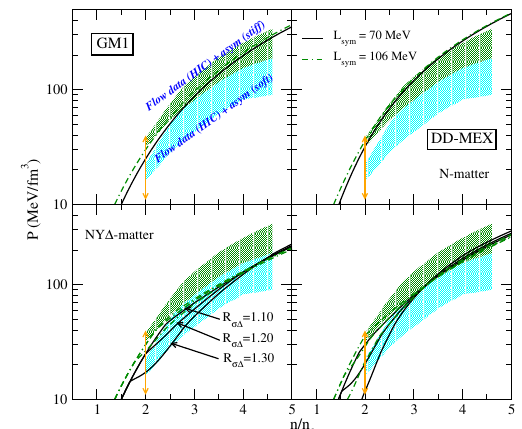
Figure 1. The matter pressure as a function of baryon number density for the nucleonic (upper panels), ∆ -admixed hypernuclear (lower panels) dense matter EOSs considering variation in L sym ( n 0 ) and scalar meson- ∆ coupling values. Re-calibrated L sym ( n 0 ) = 70 , 106 MeV EOSs are designated via the solid and dot-dashed curves respectively. The vertical bound at 2 n 0 is depicted from GW170817 event data via interpolation [16]. The shaded regions from density range (2 − 4 . 5) n 0 depict the flow data from HIC and modelled with sti ff er as well as softer EOSs [29].